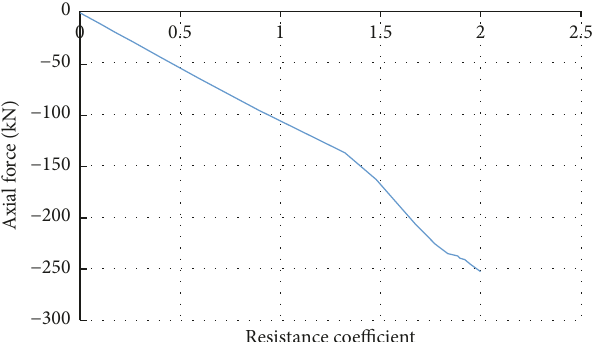
Figure 18: Axial force-resistance coefficient curve of the steel beam connected with the removed corner column. Table 3: Beam dimension and corresponding beam-to-column linear stiffness ratios (models ( 4 )–( 7 )). Beam dimension (mm) Model